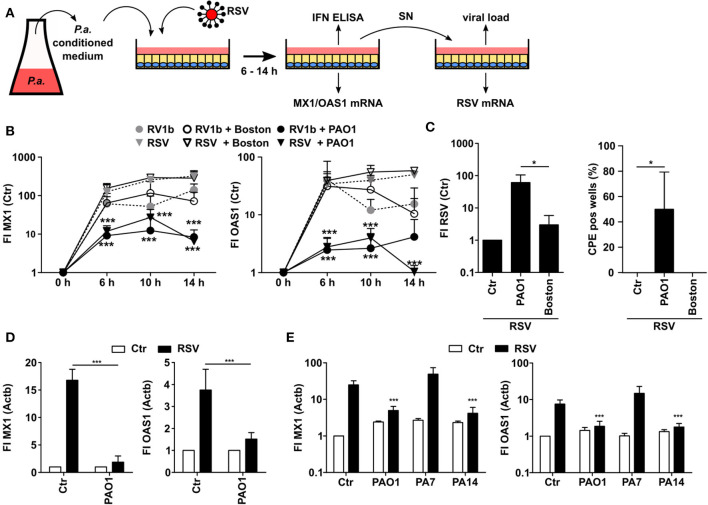
P. aeruginosa is able to suppress antiviral response of airway epithelial cells. (A) Cell culture based experimental workflow. (B) BEAS2B cells were pretreated with conditioned medium of P. aeruginosa (PAO1 and Boston) or control medium and subsequently infected with RSV or RV1b. Induction of MX1 and OAS1 mRNA were analyzed by qRT-PCR after 6, 10, and 14 h. (C) BEAS2B cells were treated as in (A) and cell culture supernatant of RV1b (human RV) or RSV infected cells (14 h) was transferred to new BEAS2B cells. Levels of RV1b (hRV) or RSV mRNA were analyzed by qRT-PCR and the number of wells displaying RV1b or RSV specific cytopathogenic effects (CPE) was determined. (D) Primary HBE cells were pretreated with conditioned medium of P. aeruginosa (PAO1) or control medium and subsequently infected with RSV. Induction of MX1 and OAS1 mRNA were analyzed by qRT-PCR after 14 h. (E) BEAS2B cells were pretreated with conditioned medium of P. aeruginosa or control medium and subsequently infected with RSV. Induction of MX1 and OAS1 mRNA were analyzed by qRT-PCR after 14 h. All experiments n = 3–4, ANOVA and Bonferroni post-test was used for statistical analysis. Significant differences were considered at *p < 0.05, **p < 0.01, and ***p < 0.001 as compared to the control condition. n.s., not significant.